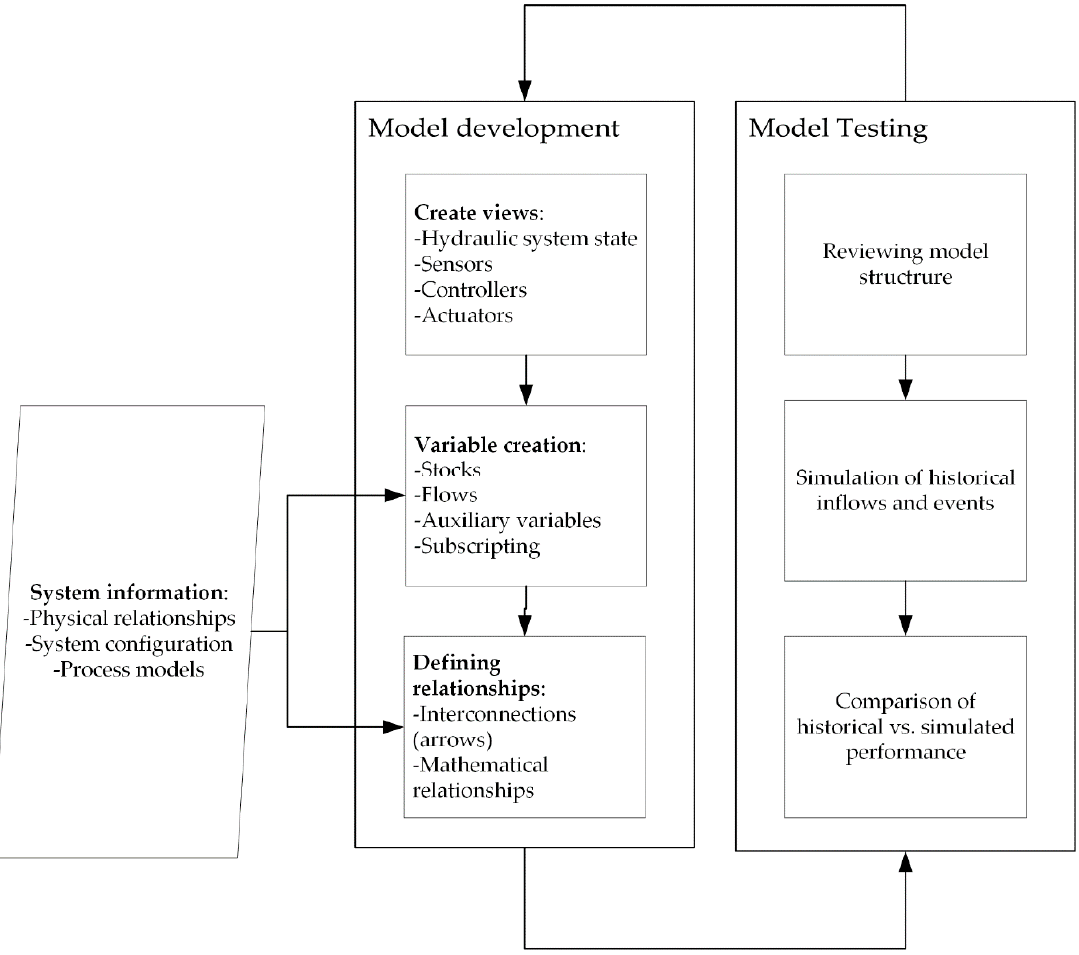
Figure 9. Simulation model development flow chart.